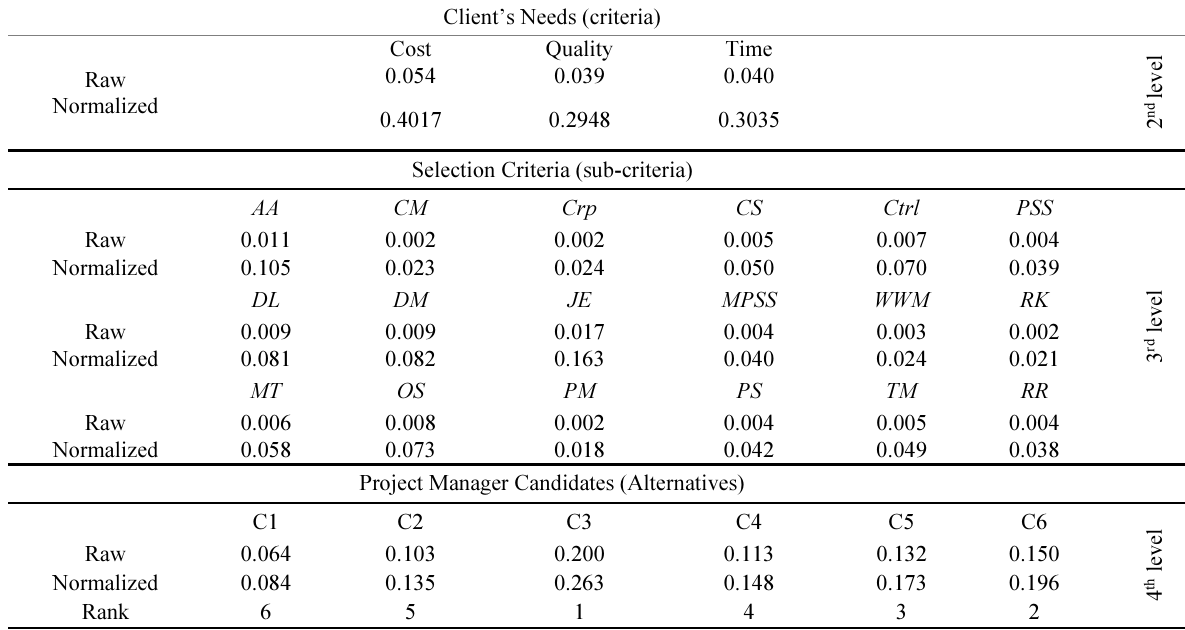
Table 7. Overall priorities of client needs, project manager selection criteria and candidates Client’s Needs